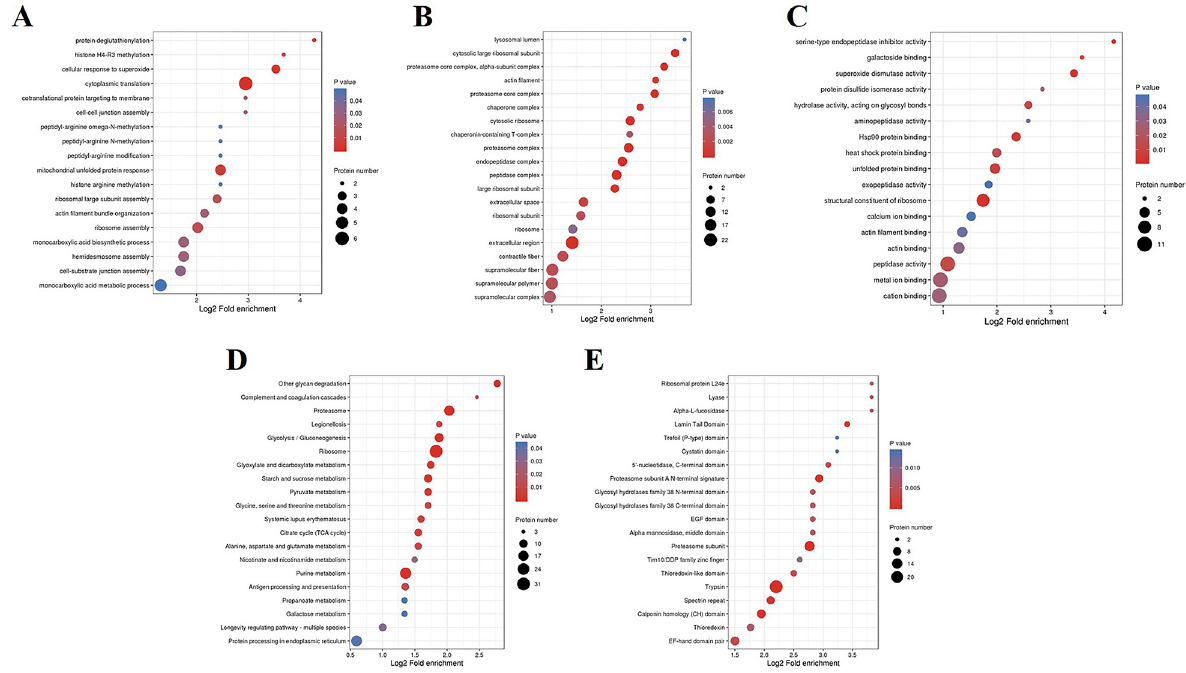
Fig 3. Enrichment analyses of the proteins derived from Ts -ML-EVs. Enrichment analyses by “Biological process” (A), “Cell component” (B), “Molecular function” (C), KEGG pathway (D), and (E), protein domain.